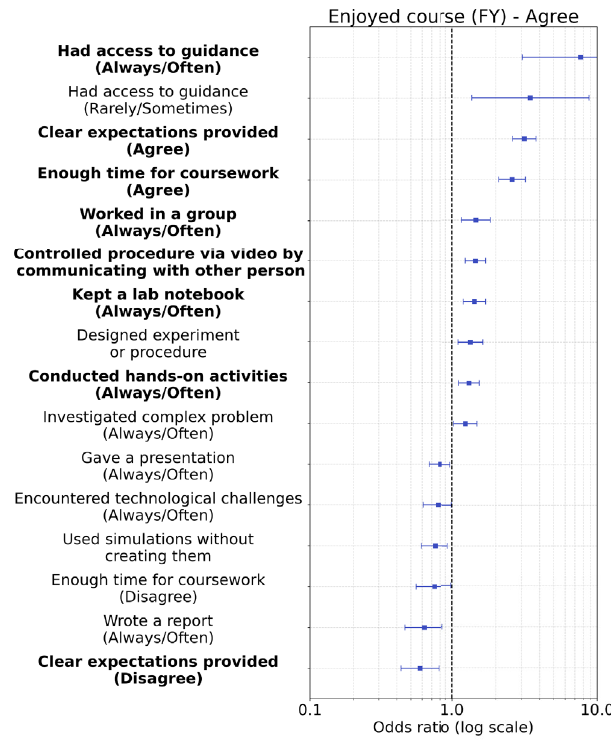
FIG. 9. Logistic regression odds ratios for students who agreed or strongly agreed that they enjoyed their course compared with all other students. Only variables with uncor- rected p values less than 0.05 are shown. Bold variables are those that are statistically significant after the Holm-Bonferroni correction. Error bars show 95% confidence intervals. The odds ratios are on a log scale to make the positive and negative effects be of approximately equal